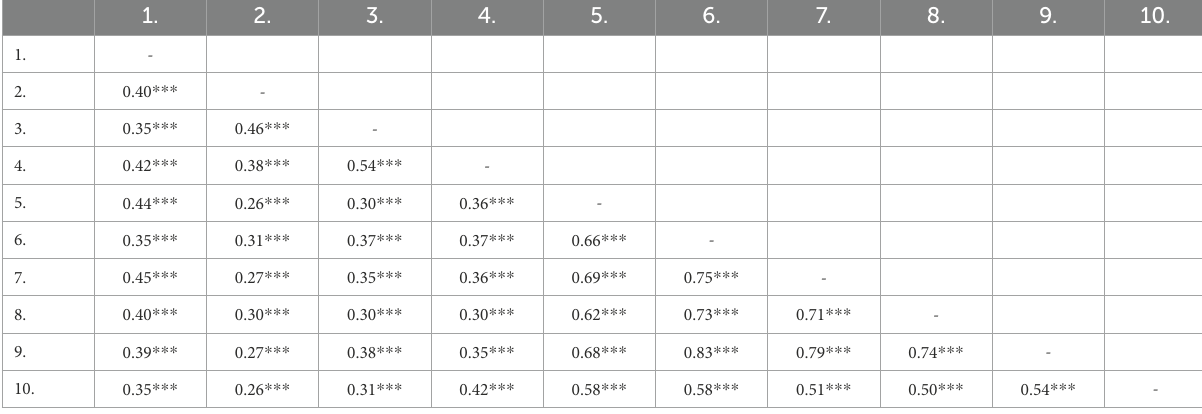
TABLE 3 Zero-order correlations between indicator, mediator, and outcome variables in hypothesized mediation model ( N = 345).